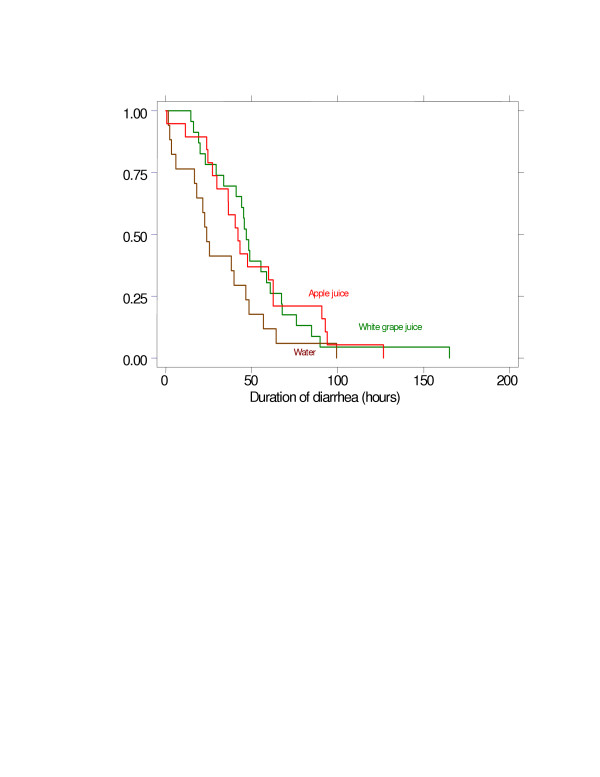
Survival analysis of total of diarrhea – Kaplan-Meier, per group. * Statistic difference were found, p < 0,05, among water group and apple juice (P = 0,03) or white grape juice (P = 0,00).